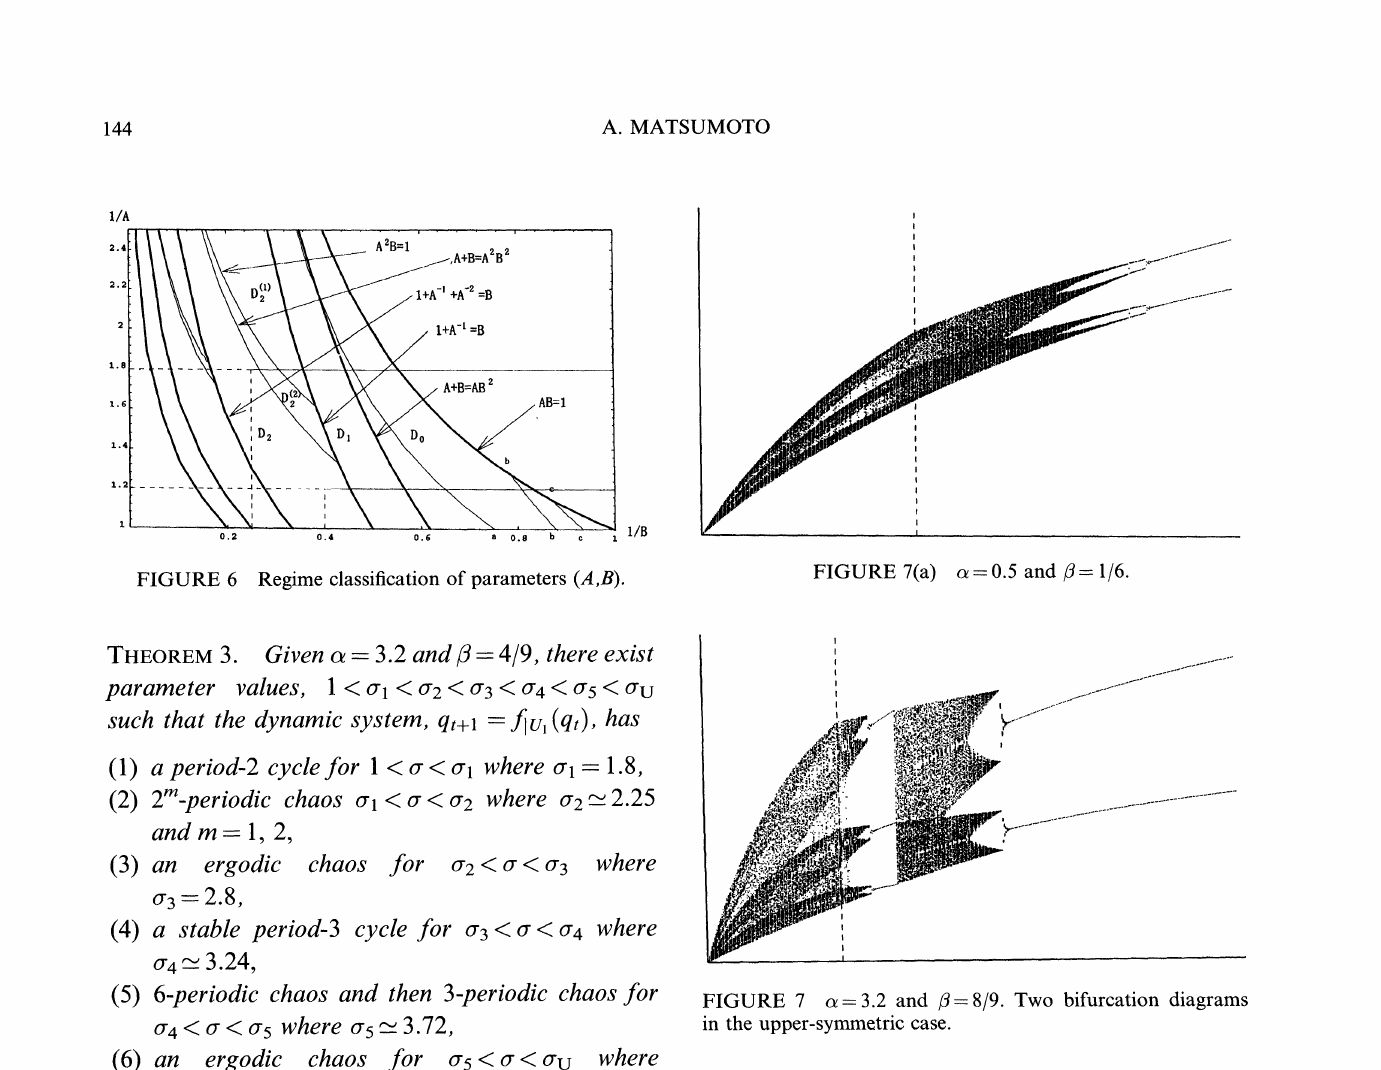
1/B FIGURE 7(a) a=0.5 and/3= 1/6.